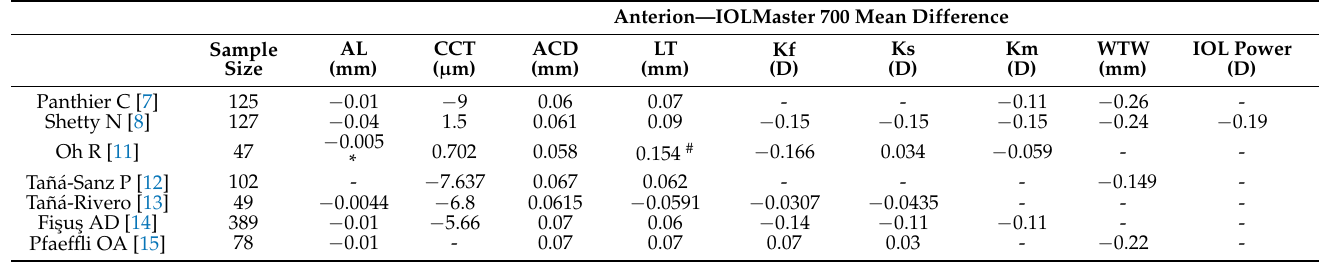
Table 4. Summary of the published ocular parameters differences between the two devices. Anterion—IOLMaster 700 Mean